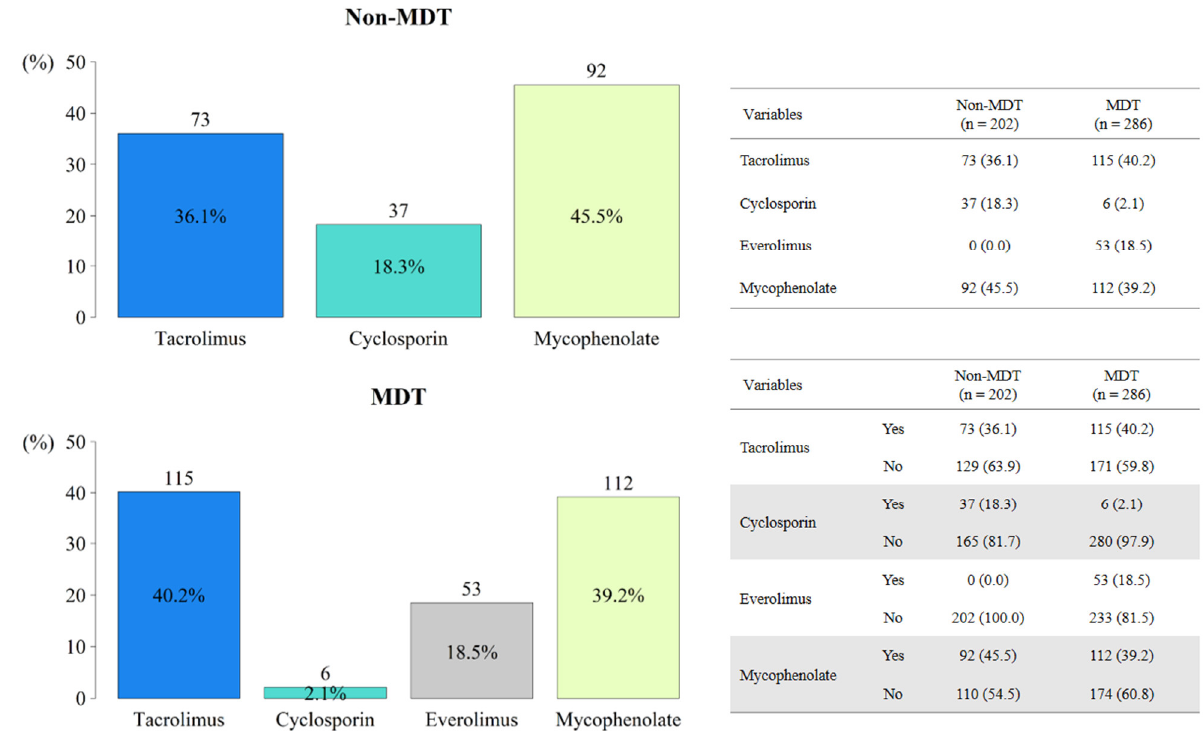
Figure 2. Use of immunosuppressive agents at three months after heart transplantation. MDT, multidisciplinary team. Table 2. Operative and postoperative characteristics of all patients.